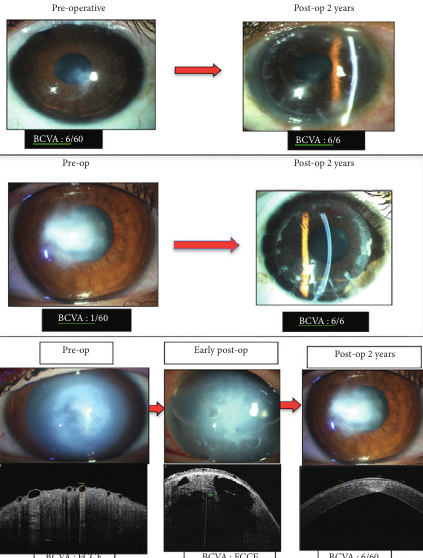
Figure 2: Preoperative and postoperative (2 years) photograph of a representative KC case that underwent (a) DALK, (b) PK, and (c) intracameral C 3 F 8 gas injection in acute hydrops cases, with corresponding changes in AS-OCT